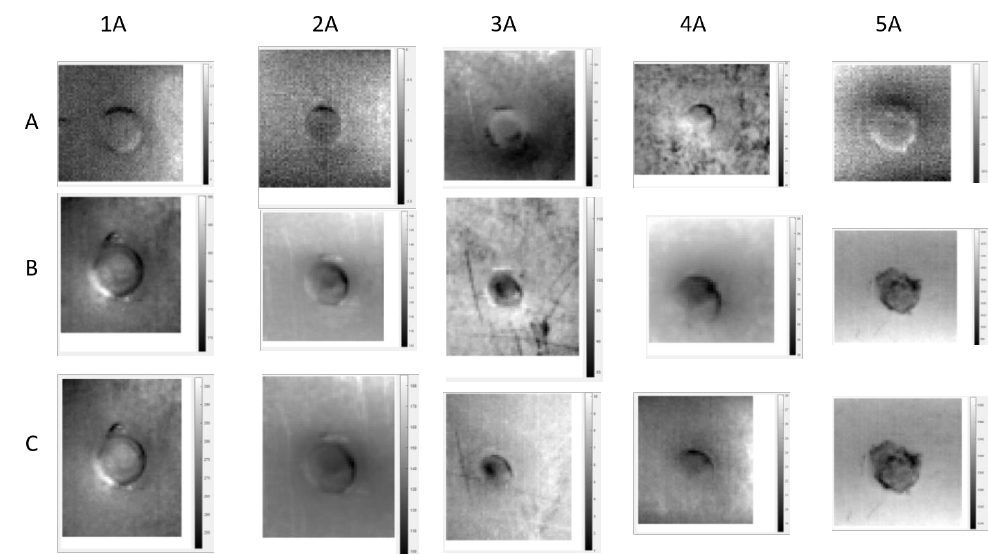
Figure 8. Images taken from the principle component analysis performed on the thermal data captured using induction heating of the front side of the sample. Experiment ( A ) is performed using an induction time of 5 s, experiment ( B ) has an induction time of 10 s, and the sample was heated for 19 s in experiment ( C ).